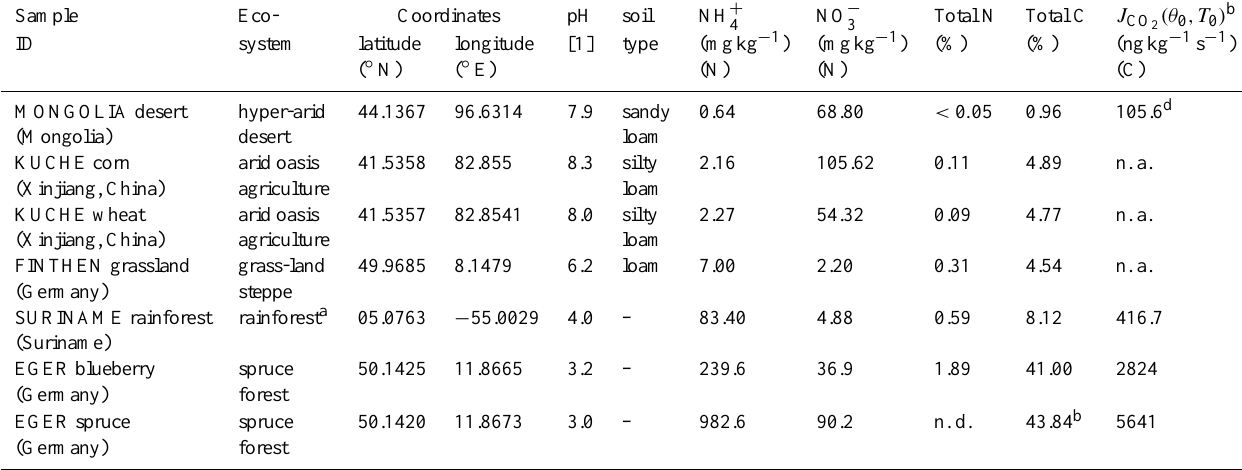
Table 1. Compilation of soil properties of all soil samples used in this study. All soil samples have been taken from the top soil of corre- sponding ecosystems (0–5cm depth).